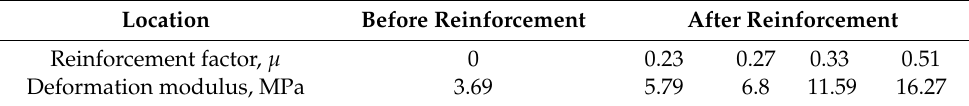
Table 2. Summary of the in-situ deformation modulus before and after the reinforcement.